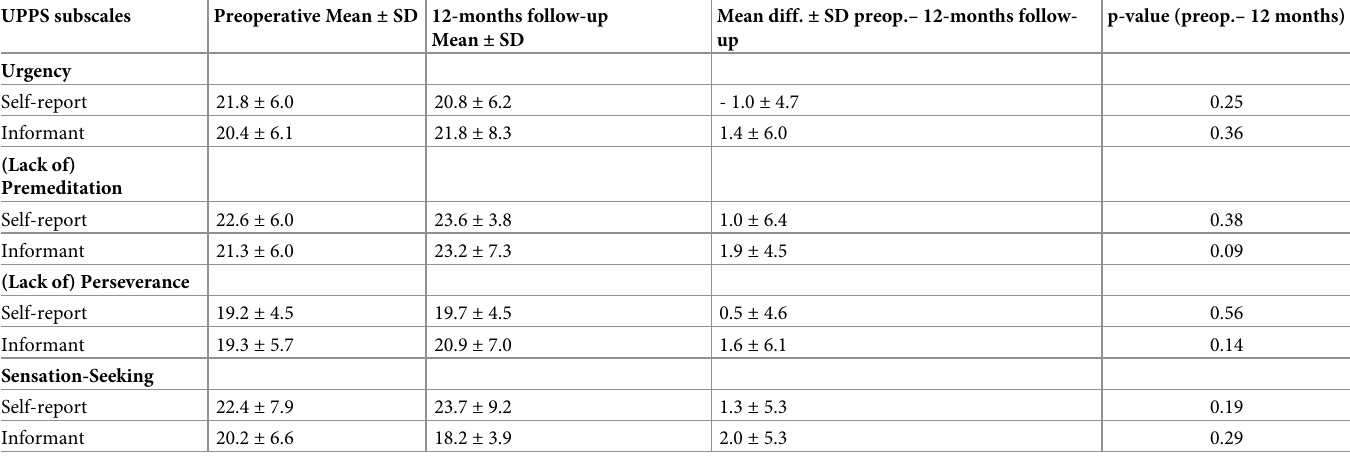
Table 3. The Urgency, Premeditation, Perseverance and Sensation Seeking impulse behavior scale (UPPS) self-reported and informant scores preoperatively and at 12 months follow-up. UPPS